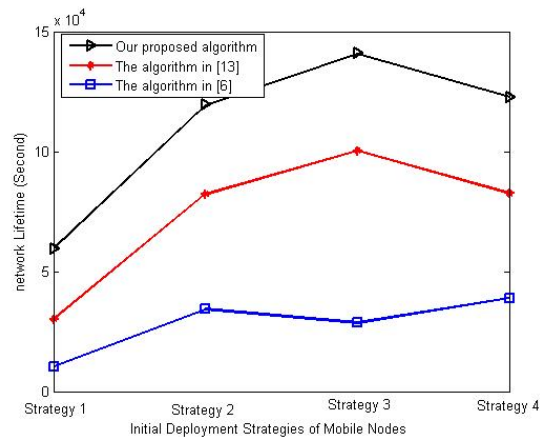
Table 6. Initial deployment strategies.